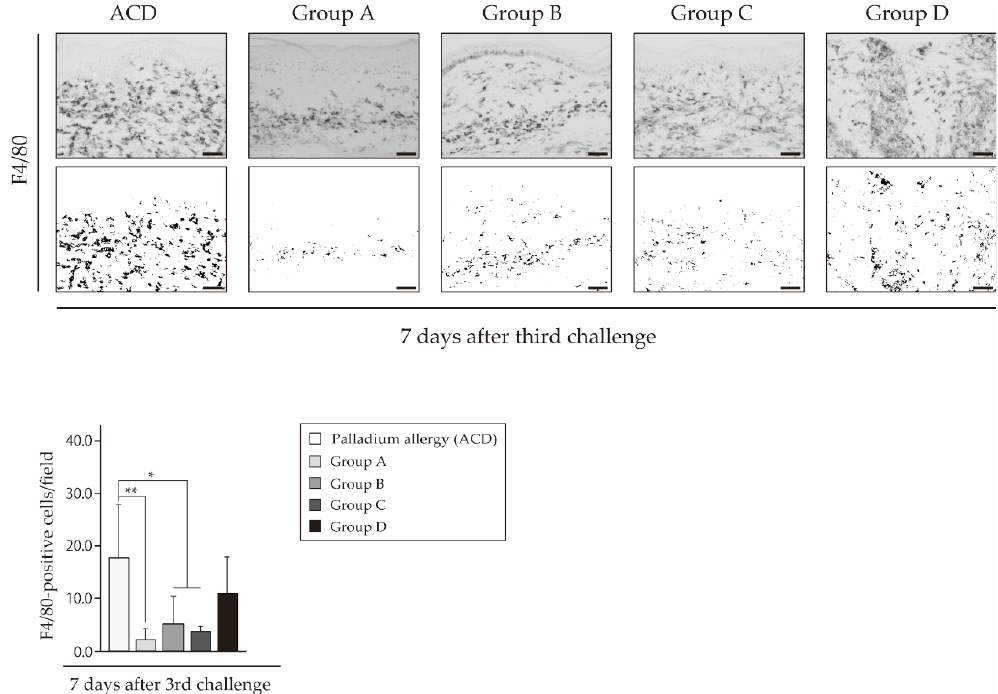
Figure 5. Imaging calculation of F4/80-positive cells. Measurements were made in six different regions of each sample, and mean values were used for statistical analysis. The figure show the representative photos of each group. The number of F4/80-positive cells at 7 days after the last challenge per target area was counted using ImageJ software with Java-based color deconvolution (v. 1.41). Bars and error bars indicate the mean + standard deviation (SD). * p < 0.05 is considered as significant, and ** p < 0.01 is considered as very significant. Scale bar = 100 µm.